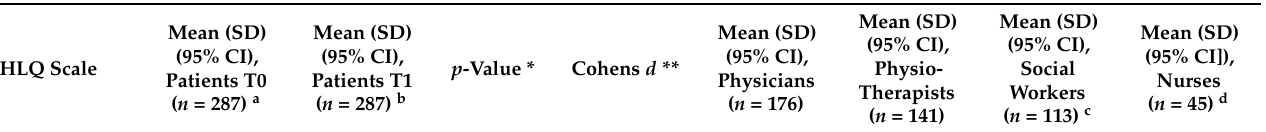
Table 2. Patients (T0, T1)—Health Literacy Questionnaire (HLQ) scale scores and t -tests for dependent samples; HCPs (T0)—Health Literacy Questionnaire (HLQ) scale